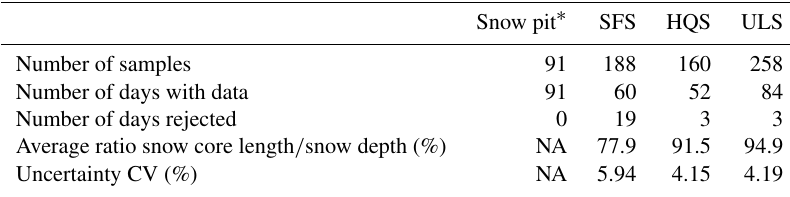
Table 2. SWE measurements for snow samplers and snow